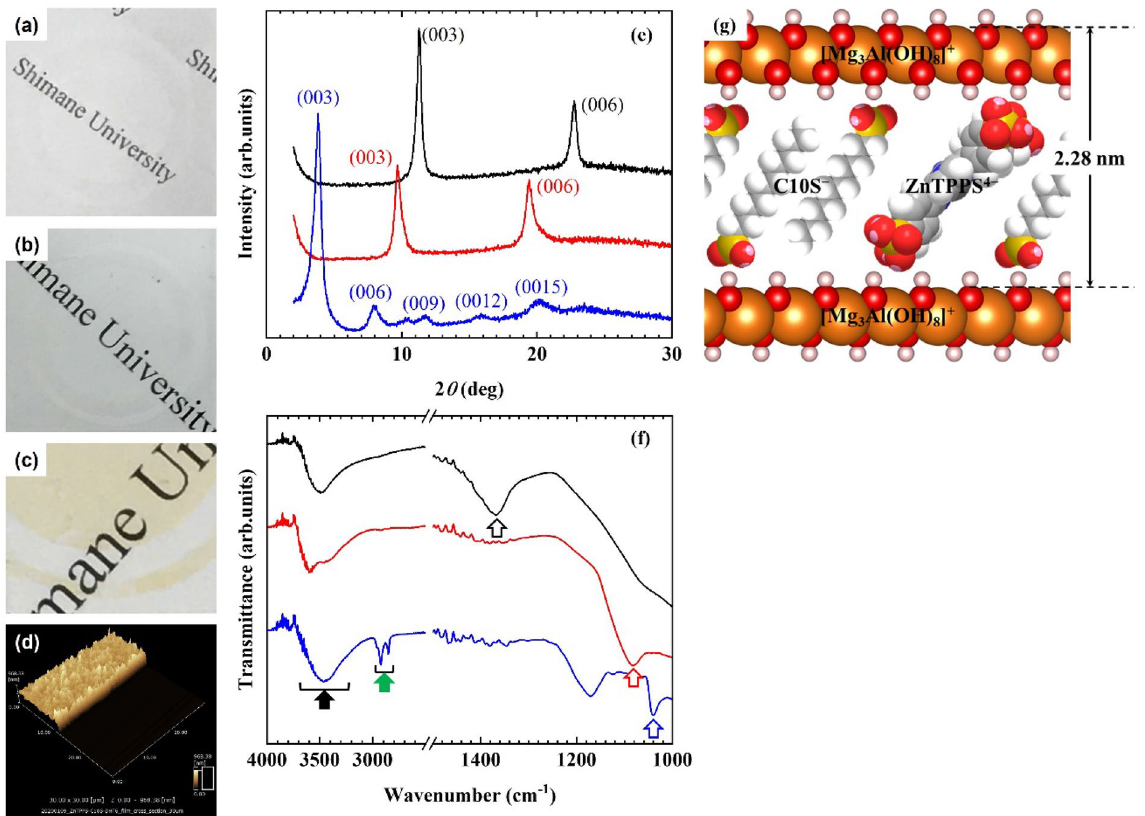
Figure 1. Photographic images of the (a) CO 3 2− -LDH, (b) ClO 4 − -LDH, and (c) ZnTPPS/C10S/LDH transparent films. (d) AFM image of the transparent ZnTPPS/C10S/LDH film. (e) XRD patterns of the CO 3 2− -LDH (black solid line), ClO 4 − -LDH (red solid line), and ZnTPPS/C10S/LDH transparent films (blue solid line). (f) FT-IR spectra of the CO 3 2− -LDH (black solid line), ClO 4 − -LDH (red solid line), and transparent ZnTPPS/ C10S/LDH films (blue solid line). Arrows indicate the peaks originating from the hydroxyl (black), carbonate (black (open)), methylene (green), perchlorate (red (open)) and sulfonate (blue (open)) groups. (g) Schematic structural model of the ZnTPPS/C10S/LDH